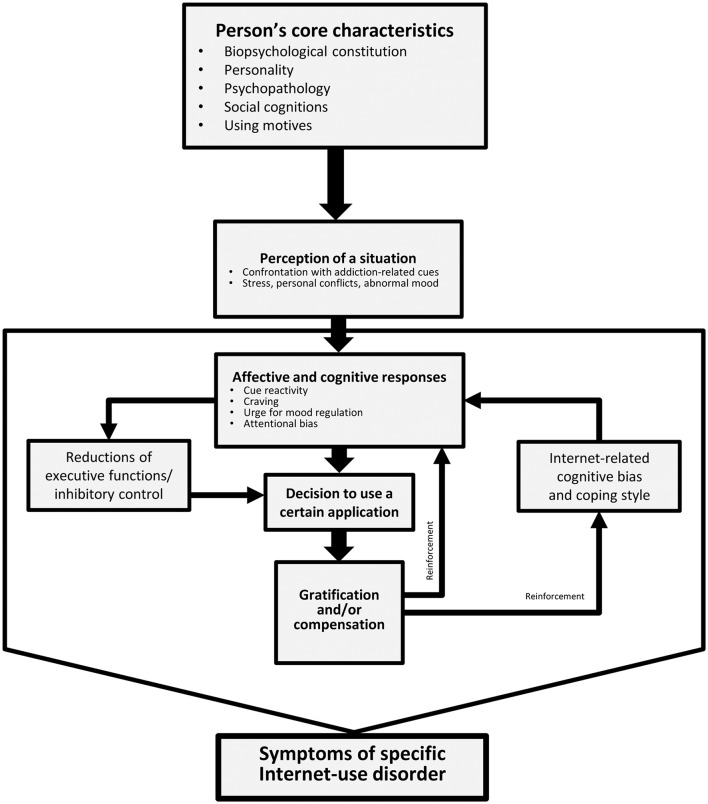
Reduced version of the I-PACE model (Brand et al., 2016).